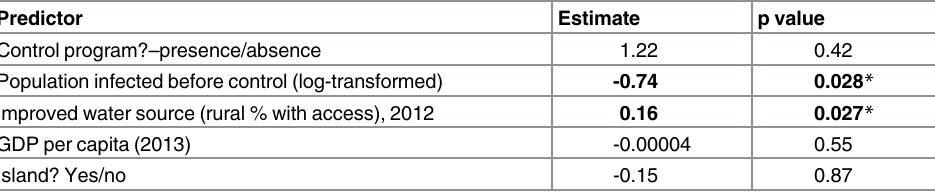
Table 2. Logistic regression for elimination/non-endemicity.